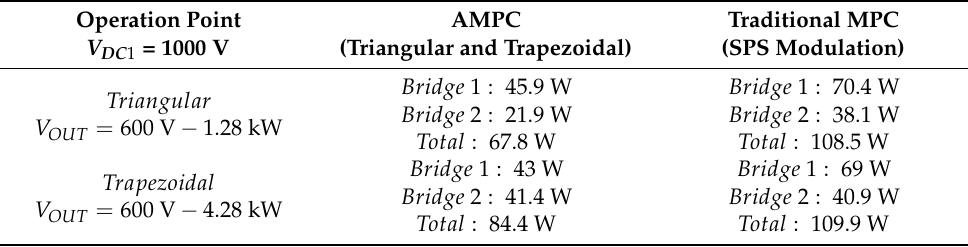
Figure 17. Waveforms ( a ) mode 1: buck triangular modulation; ( b ) mode 2: buck trapezoidal modulation; ( c ) mode 3: boost triangular modulation; ( d ) mode 4: boost trapezoidal modulation. Table 3. Losses in primary and secondary bridges of DAB for AMPC and traditional MPC in buck